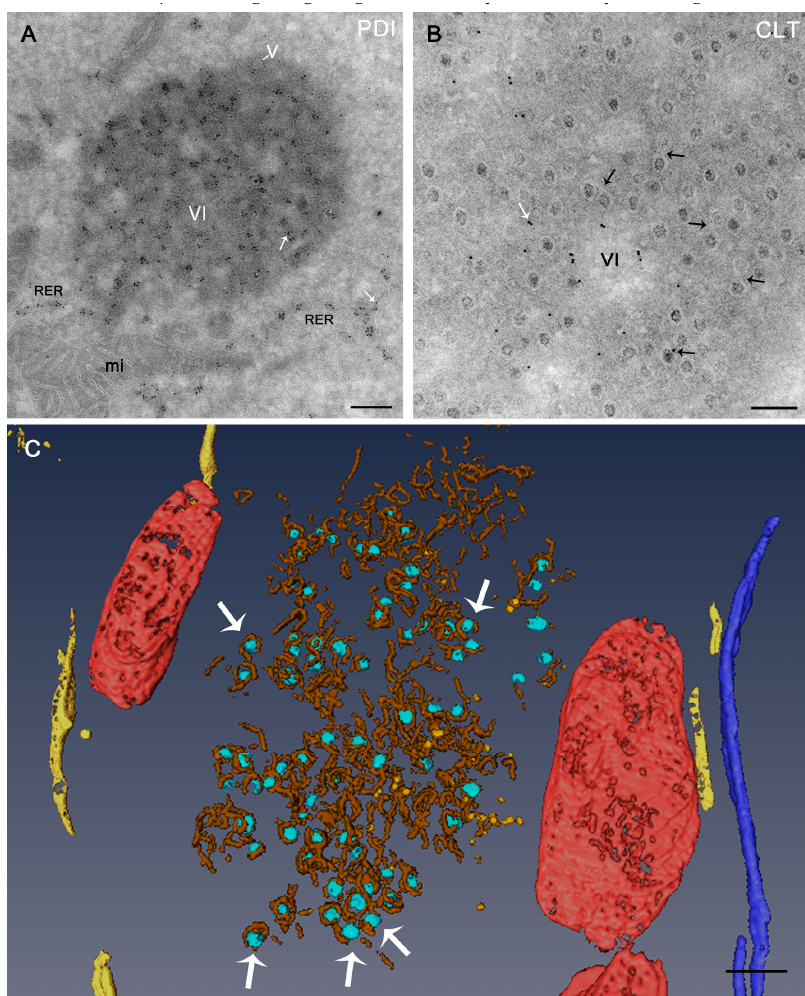
Figure 3. Reovirus inclusions contain ER membranes. ( A , B ) HeLa cells were infected with reovirus T1L M1-P208S for 14 h, frozen in liquid nitrogen, and sectioned at −120 °C. The thawed cryosections were processed for immunogold labeling with primary antibodies specific for two ER proteins—protein disulfide isomerase (PDI) ( A ) and calreticulin (CLT) ( B )—and for secondary antibodies conjugated with 10 nm colloidal gold particles. The rough ER (RER) cisternae around the VIs and membranes inside the VIs are labeled with antibodies specific for ER proteins (white arrows in A and B ). These membranes are in close contact with the viral particles (black arrows in B ). V—viral particle. ( C ) Electron tomography (ET) of a single VI. A thawed cryosection was processed by single-tilt-axis ET, 3D reconstruction, and image processing. The 3D model shows that the VI is a collection of vesicles and tubules with viral particles attached to membranes (white arrows). RER—yellow; viral particles—light blue; mitochondria—red; nuclear membrane—dark blue; tubules and membrane fragments inside the inclusion—brown; vesicles inside the inclusion—orange. Scale bars are 500 nm in ( A ) and 200 nm in ( B , C ). Modified from Tenorio et al., 2018